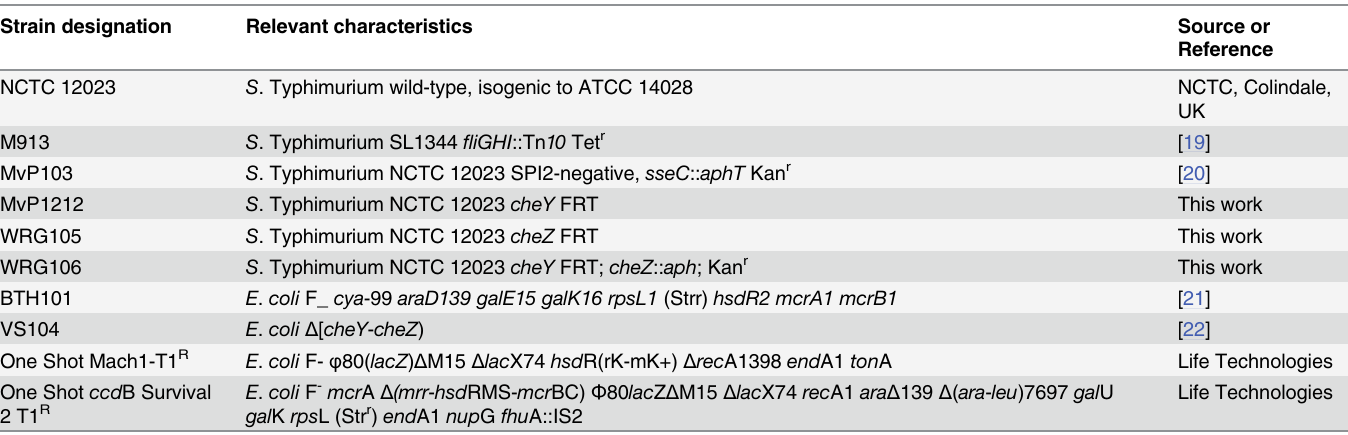
Table 1. Strains used in this